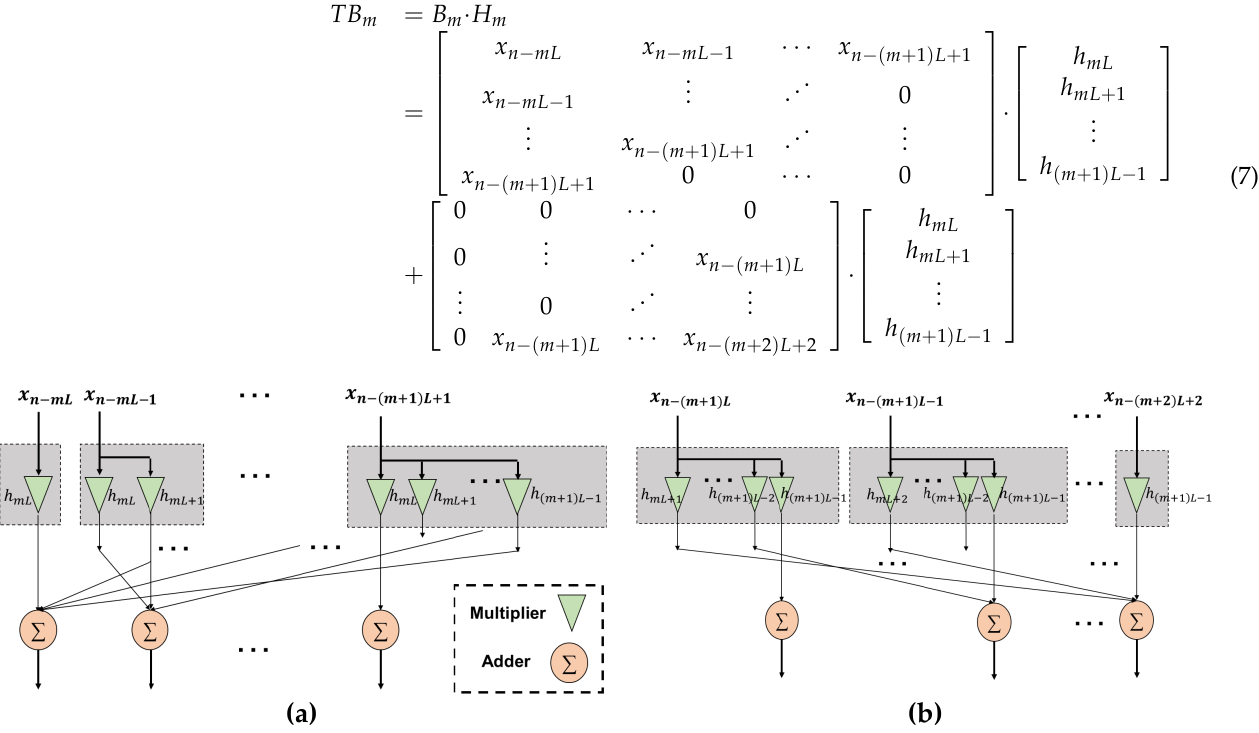
Figure 4. Implementation of the time block, 𝑇𝐵 𝑚 , with the corresponding two terms in (7) : ( a ) the form term and ( b ) the latter term.